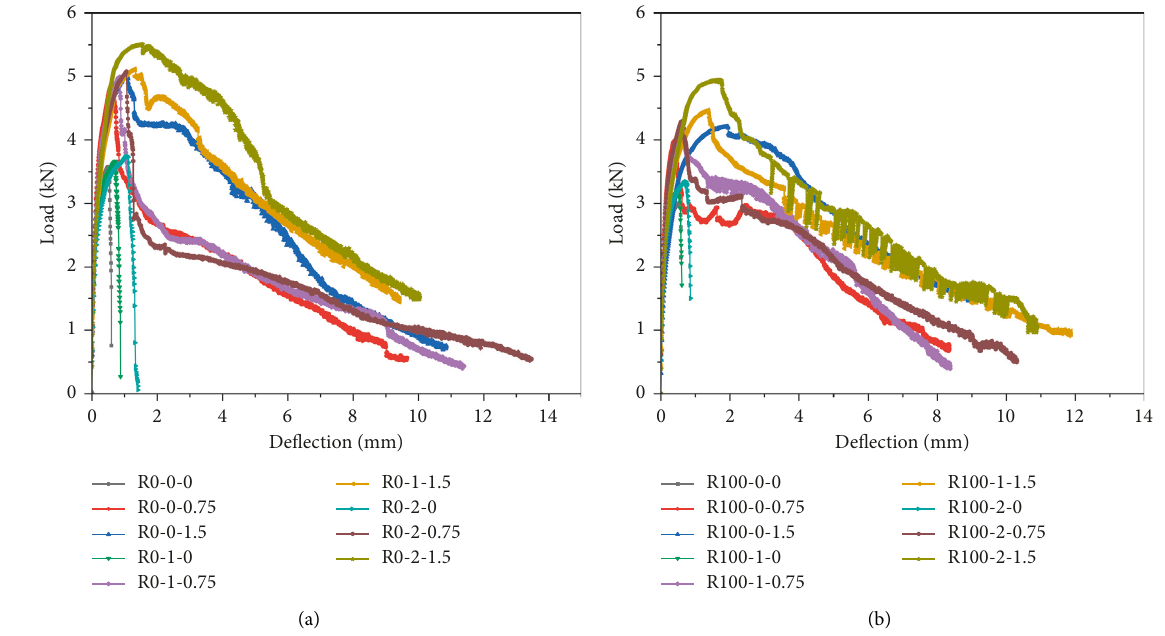
Figure 9: P - δ curves. (a) Replacement rate of 0%. (b) Replacement rate of